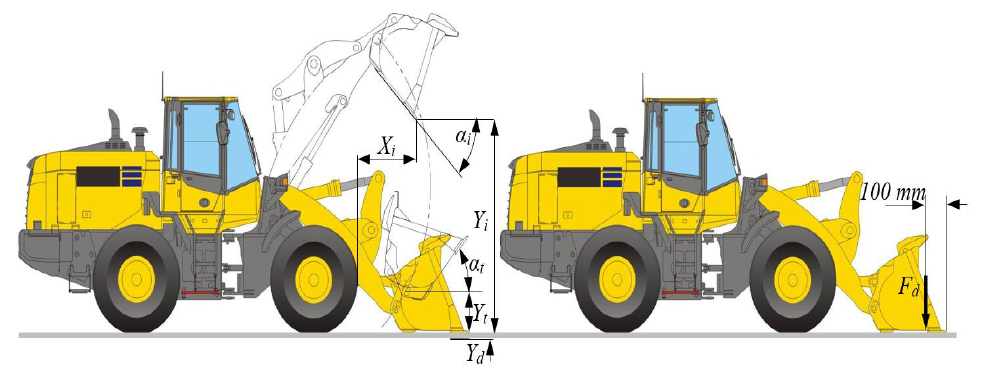
Figure 1. Input set of loader parameters.